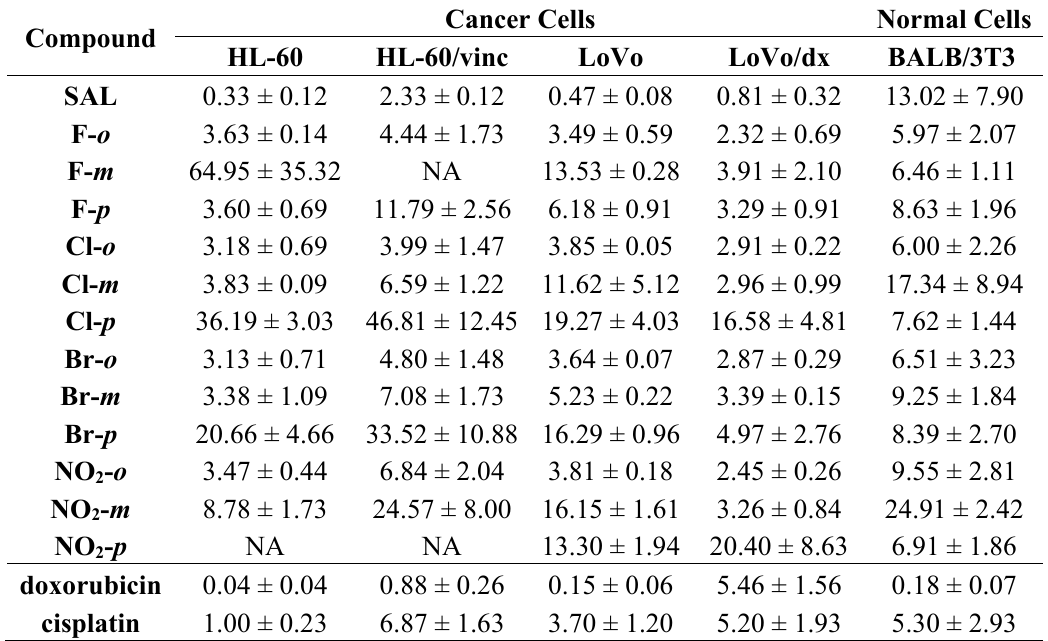
Table 3. Anticancer activity of SAL and its monosubstituted N- benzyl amides. Data are given as IC 50